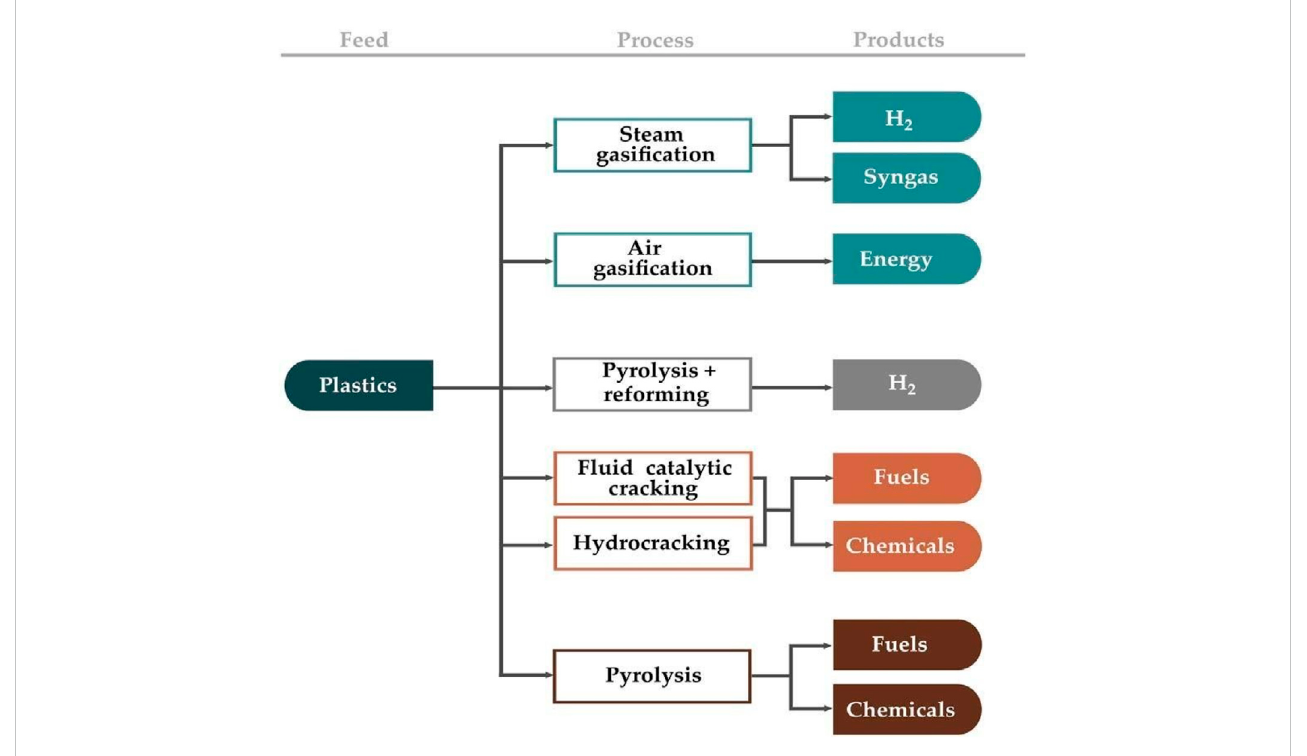
FIGURE 1 Primary chemical routes for plastic waste